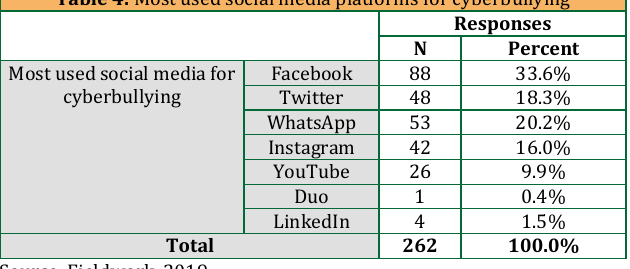
Table 4: Most used social media platforms for cyberbullying